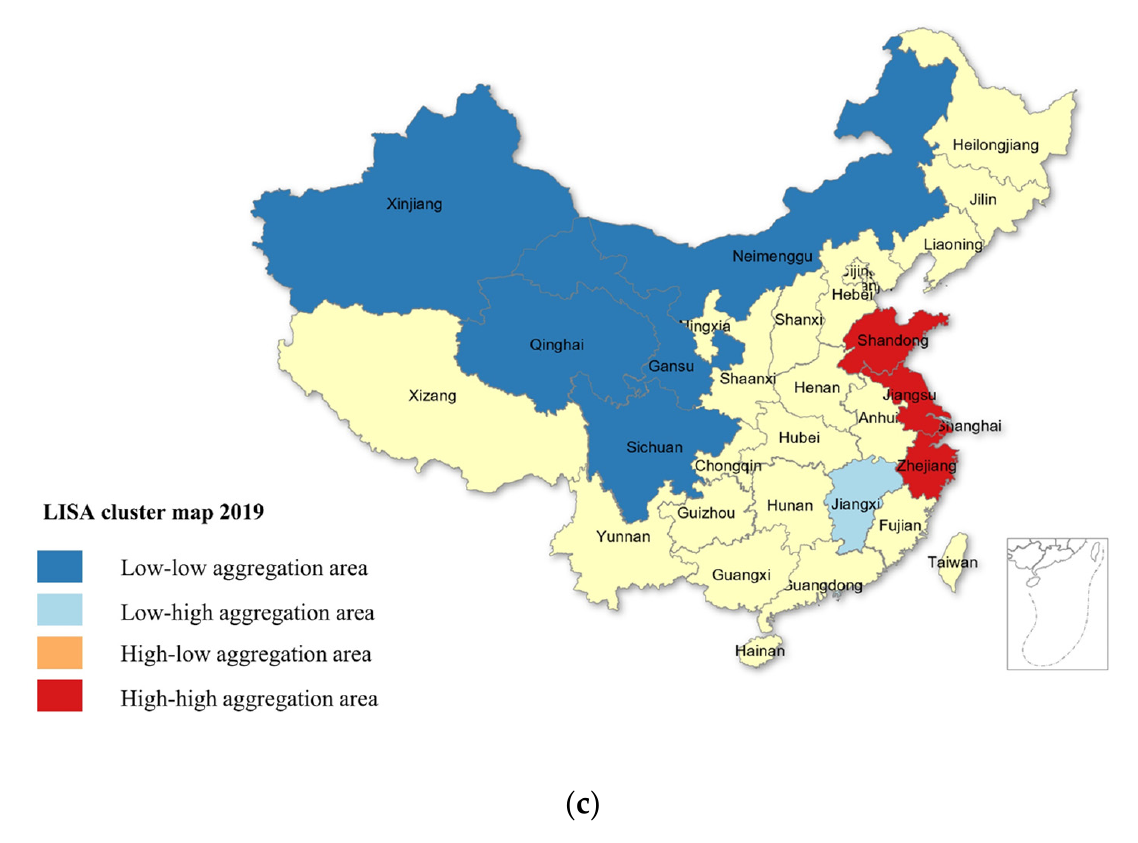
Figure 4. LISA cluster map ( a ) 2010, ( b ) 2015, and ( c ) 2019.